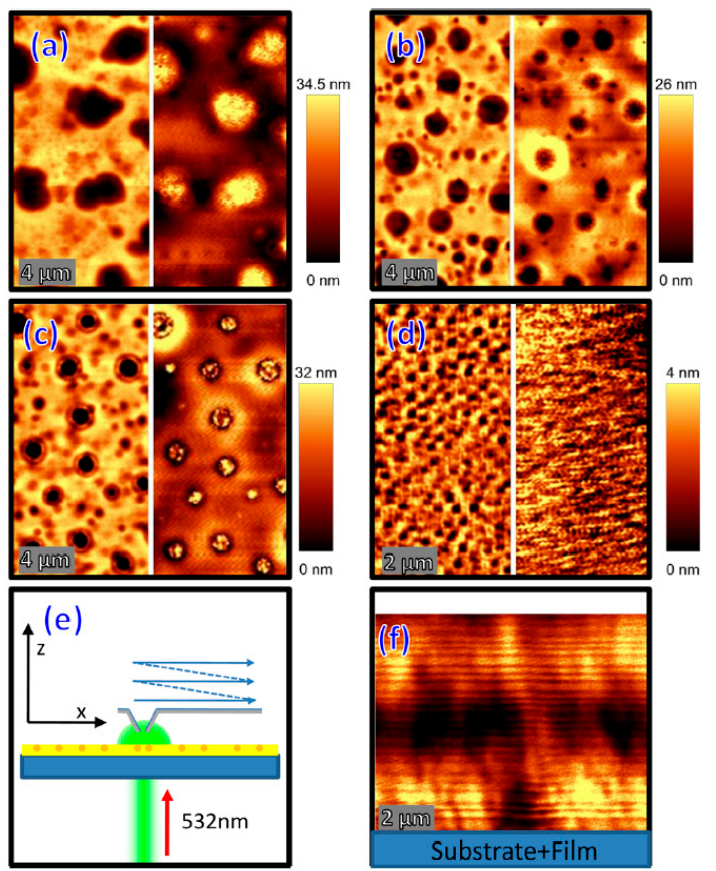
Figure 6. AFM (left) and SNOM (right) images of Au nanoparticles embedded in polyimide. ( a ) Annealing at 150 °C in an oxygen deficient environment creates large micron sized particles. Identical samples annealed at ( b ) 250 °C; and ( c ) 450 °C show a decrease in nanoparticle size as the temperature is increased; ( d ) Annealing under atmospheric conditions at 250 °C shows significantly different morphology consisting of smaller particles 250 nm in size; ( e ) Schematic of z - x c-SNOM scans using an inverted configuration with laser illumination from beneath the substrate; ( f ) Near-field light recorded moving away from the sample surface. Reproduced with permission from [54], Copyright Applied Physics Letters, 2012.